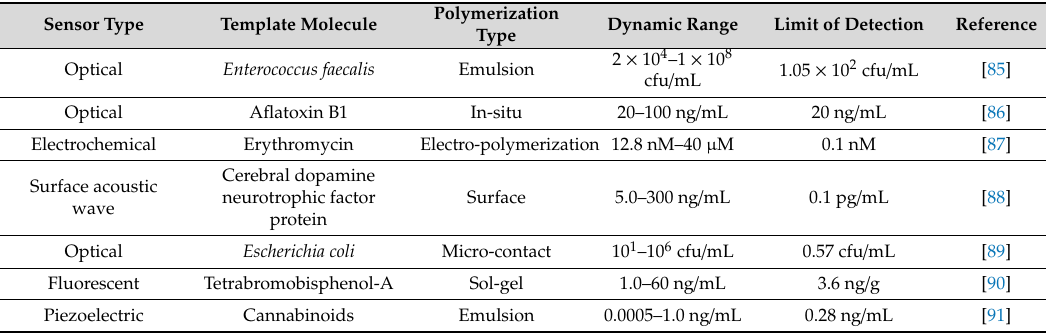
Table 3. Comparison of molecularly imprinted sensor